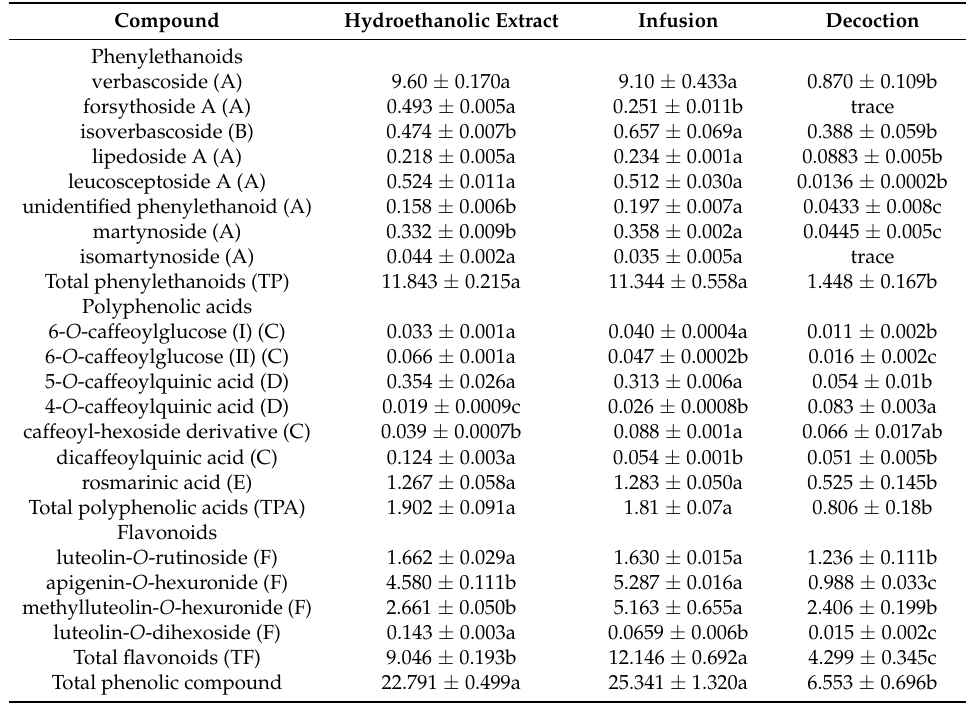
Table 2. Contents of phenolic compounds (mg/g DW) in different aerial parts of S. viridis samples (hydroethanolic extract, infusion, decoction).